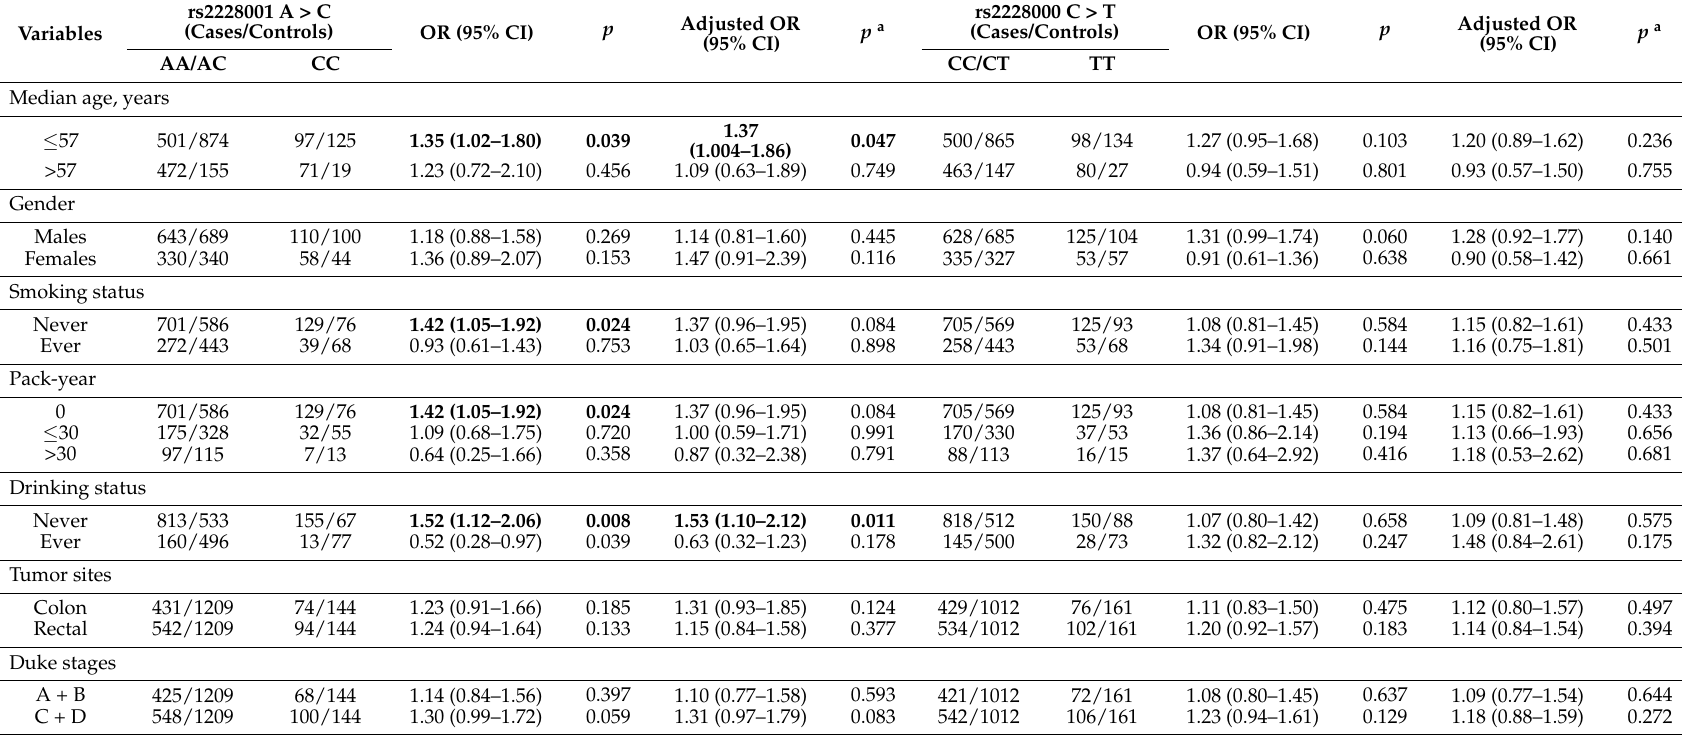
Table 3. Stratification analysis for associations between the XPC rs2228001 A > C and rs2228000 C > T genotypes with colorectal cancer